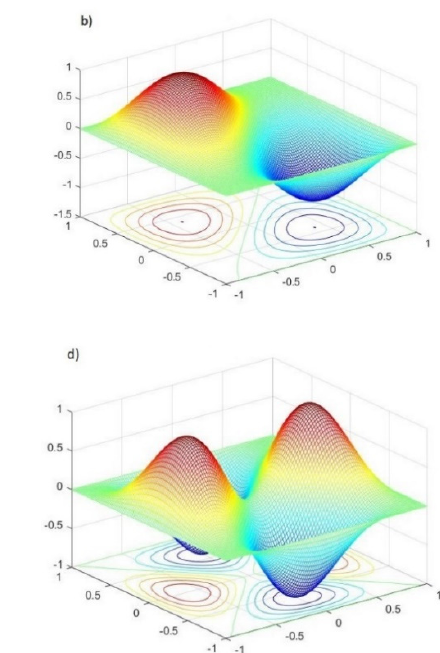
Figure 11. Vibrational modes for the SFG distribution with η = 1 and µ = 0.25: ( a ) 1st mode, ( b ) 2nd mode, ( c ) 4th mode, ( d ) 5th mode.